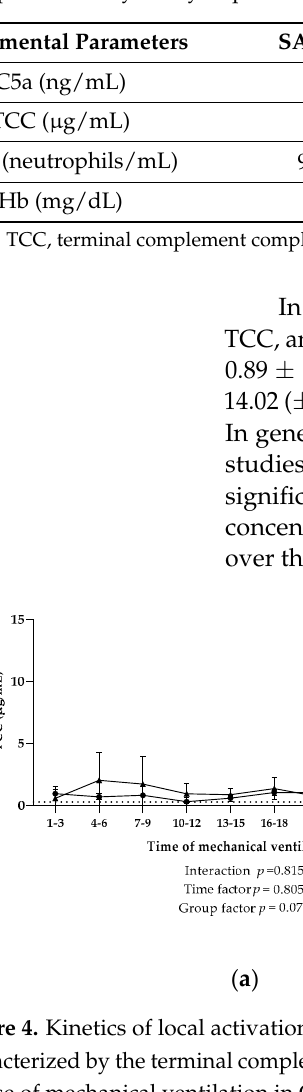
Table 2. Complement, NETosis, and hemoglobin levels in tracheal fluid of patients and healthy controls. Values represent baseline levels at first sampling time point. Data are presented as mean ± SD or n (percentage). Differences between both groups were analyzed by unpaired t -test or Mann–Whitney U test, as appropriate.